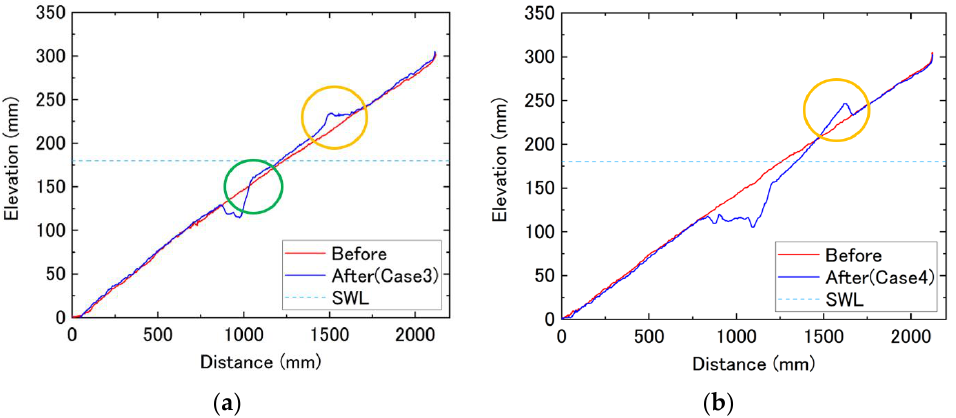
Figure 7. Topographical changes before and after the experiment: measurement of ( a ) cross-section 1 of case 3 and ( b ) cross-section 2 of case 4.